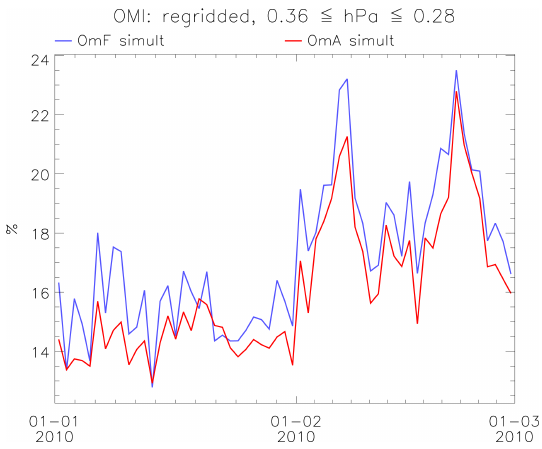
Figure 9. OMI OmF (blue) and OmA (red) for the layer around 0.3hPa, zoomed in to a month before and after the L0 to L1b pro- cessor update. The OmF and OmA have been calculated for the regridded layers from the model run with simultaneous assimilation of GOME-2 and